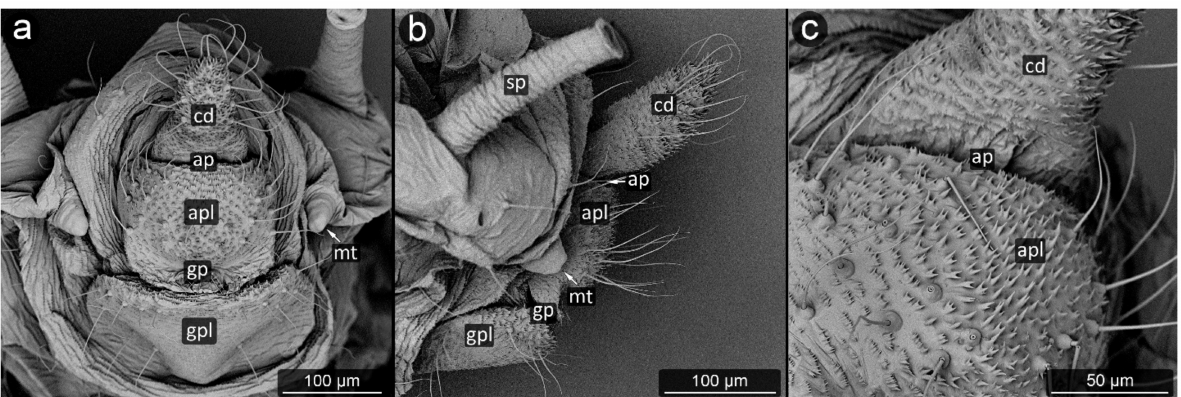
Figure 12. Perianal structure of Aphis sedi in SEM; ( a )—rear view, ( b )—lateral view, ( c )—close-up on the surface of anal plate and cauda-protruding spinules; (sp—siphunculus). Abdominal tergite VIII: with a distinct cuticular microsculpture, with two setae in its apical